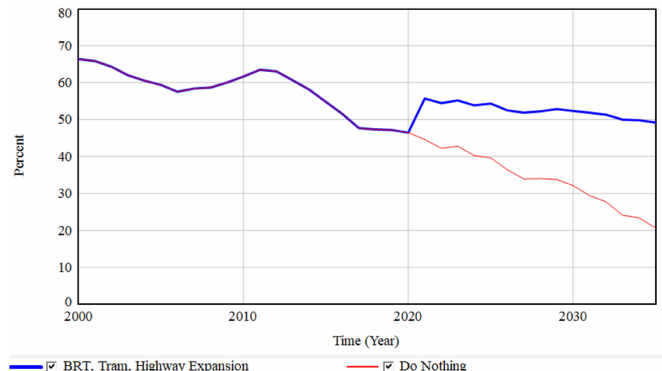
Fig. 6 Comparison of simulation result of travel time efficiency for BRT and tram projects with highway expansion